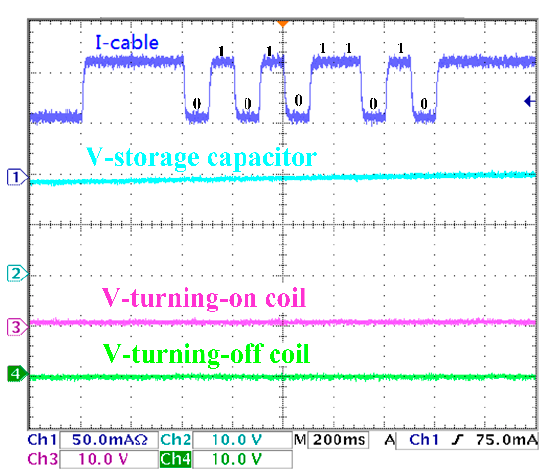
Figure 18. Turning-off command.